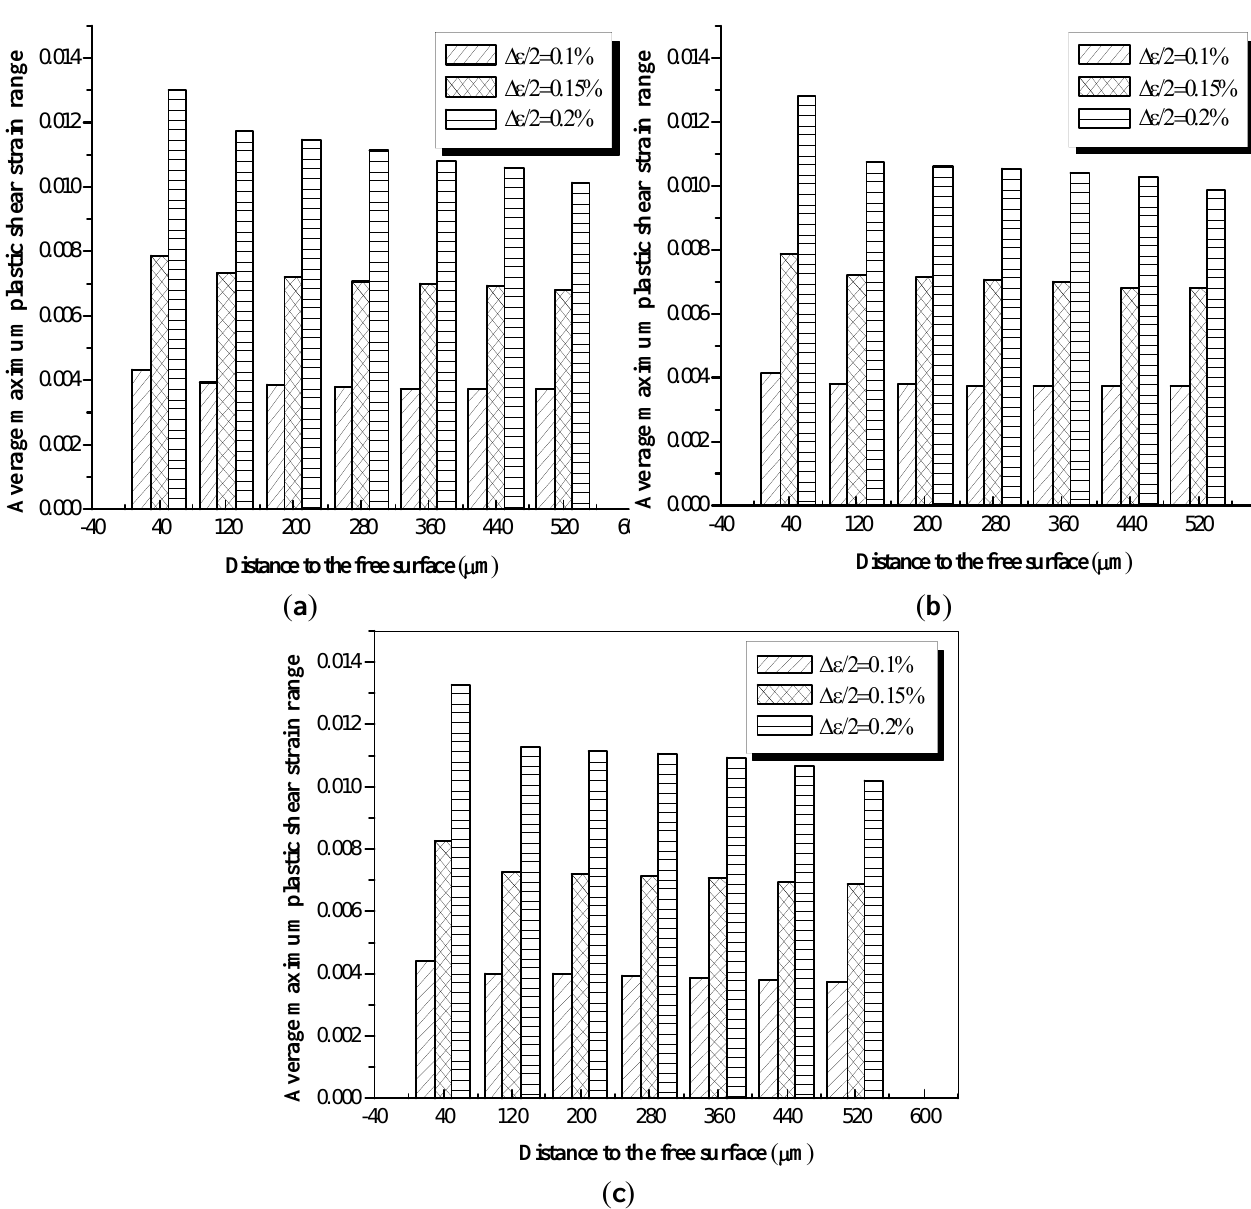
Figure 20. The effect of pores distance from free surface on the average maximum shear strain under the loading ratio of ( a ) R = 0.5; ( b ) R = 0; and ( c ) R = − 1